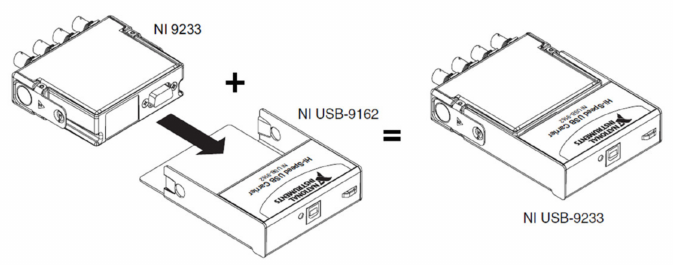
Figure 5. Scheme of NI USB-9233 data acquisition device with 4 analog input channels [66].